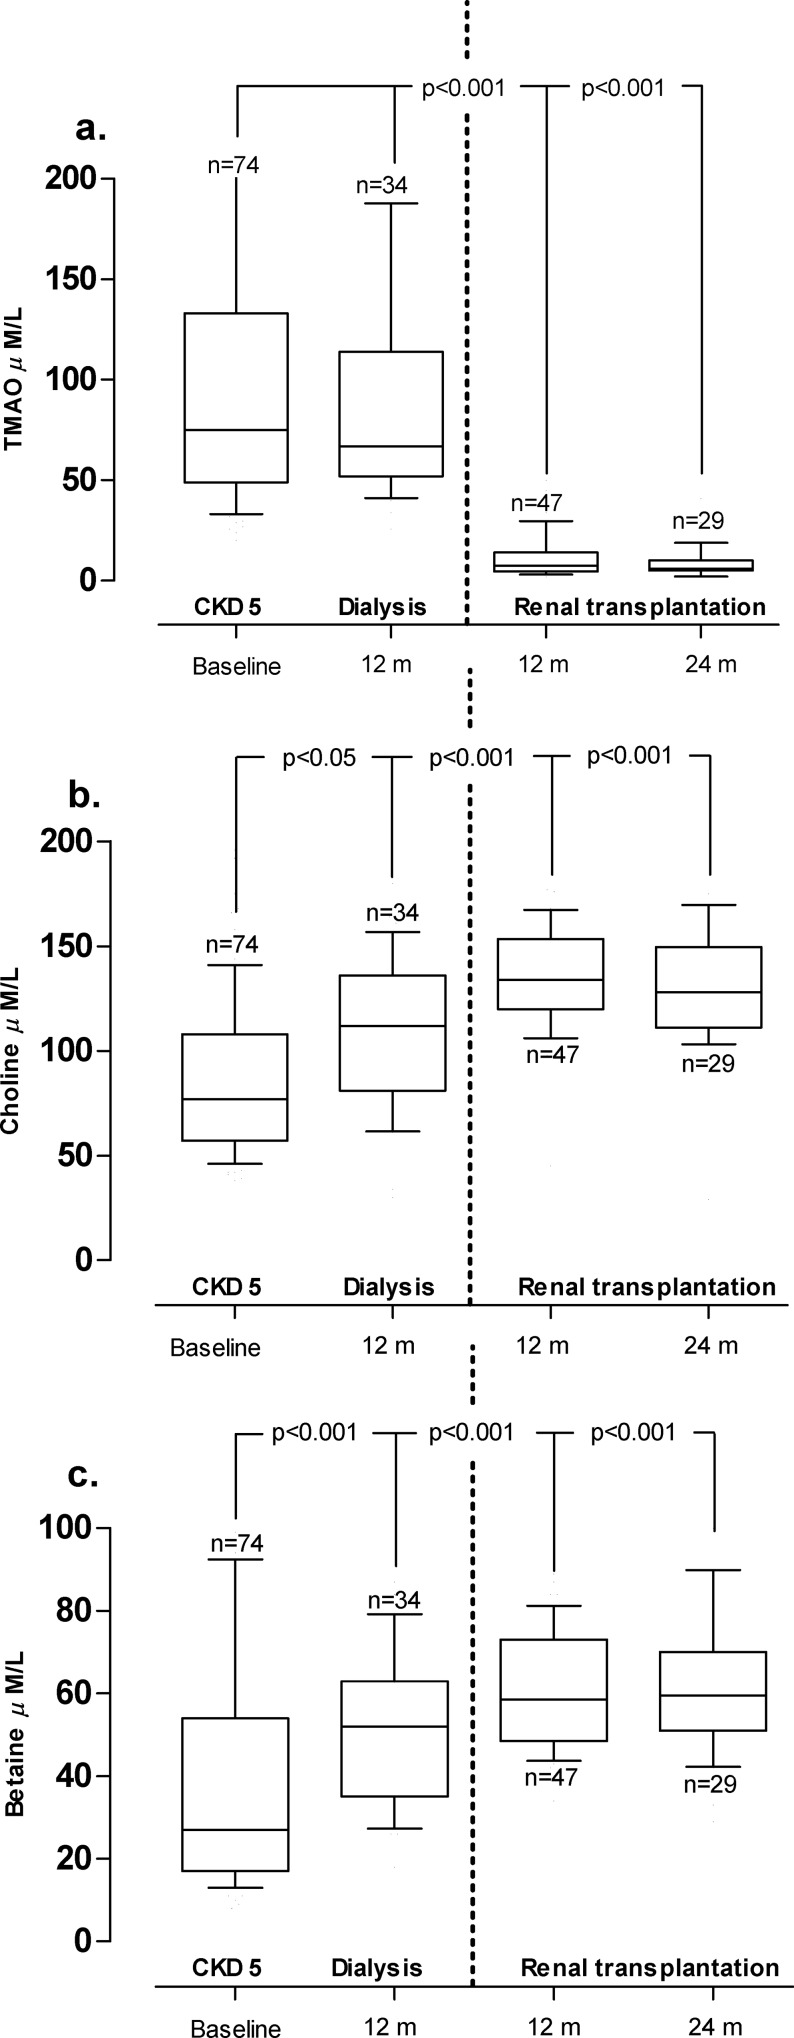
Comparison of plasma levels of metabolites in a cohort of CKD 5 patients (n = 74) followed from baseline and reassessed 12 months after start of dialysis and/or 12 months and 24 months after renal transplantation (Rtx).Choline and betaine levels increased with dialysis and Rtx whereas TMAO levels remained unchanged during dialysis and normalized after Rtx. Due to missing samples box-plots represents 34/74 patients at 12 months of dialysis, 47/74 patients at 12 months and 29/74 patients at 24 months follow-up after Rtx. Values are expressed as median (10th -90th percentile) P-values analyzed by Kruskal–Wallis’ one-way ANOVA, followed by Dunn’s multiple comparison test.